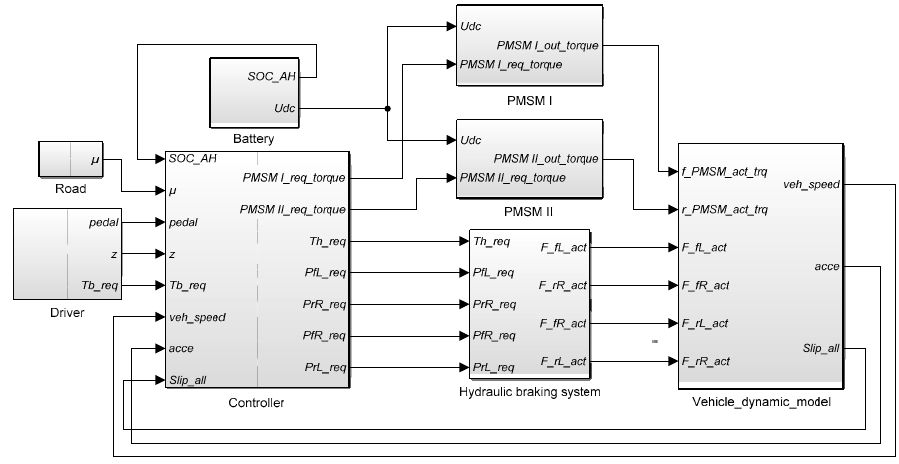
Figure 12. The simulation model of the electric vehicle.